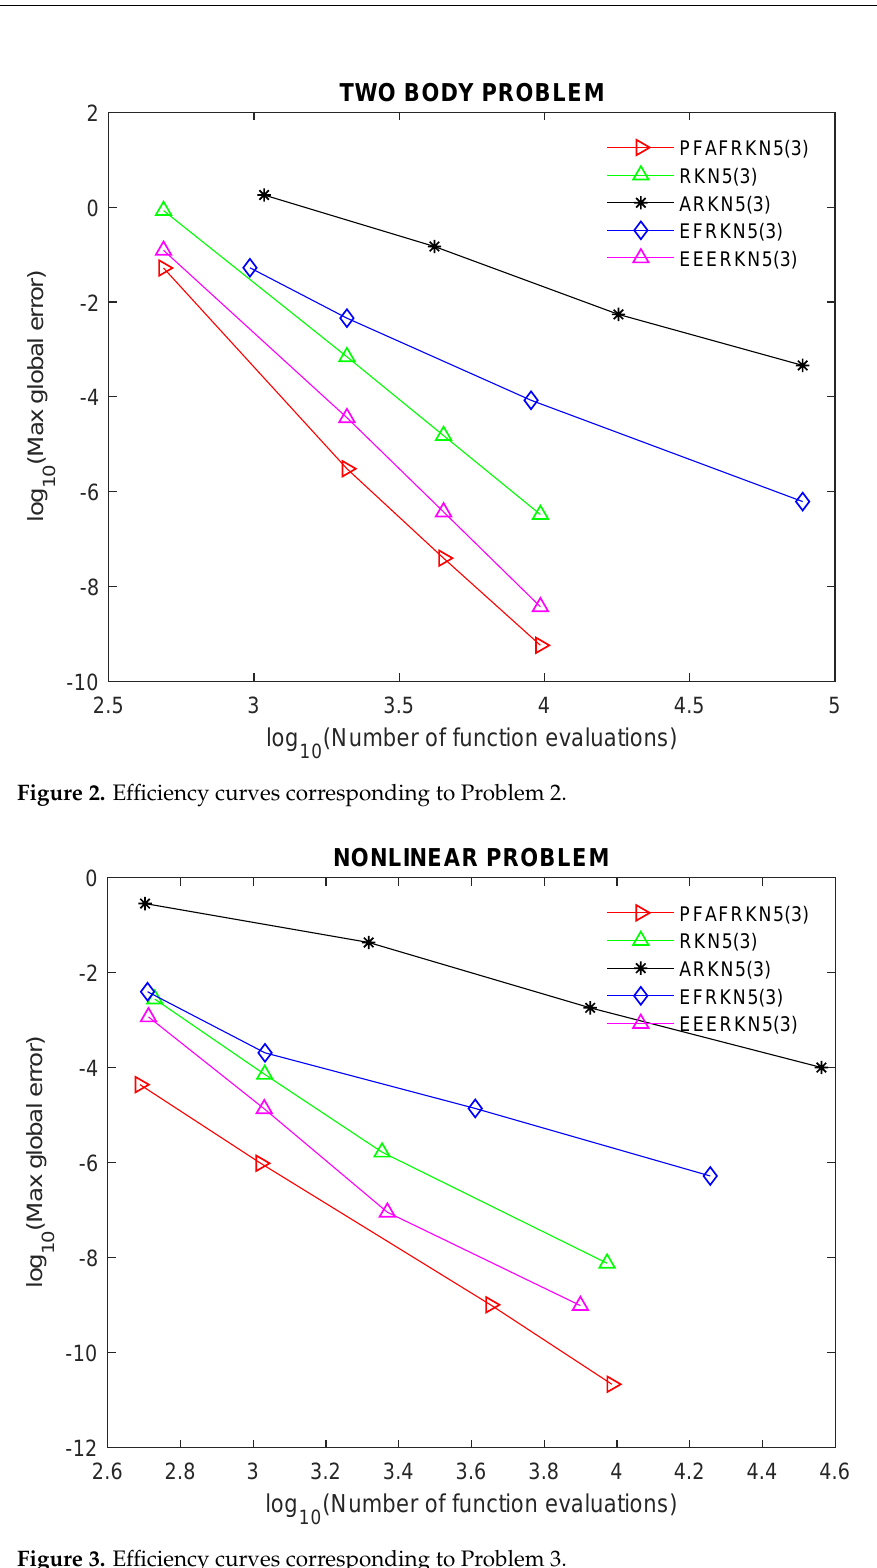
Figure 3. Efficiency curves corresponding to Problem